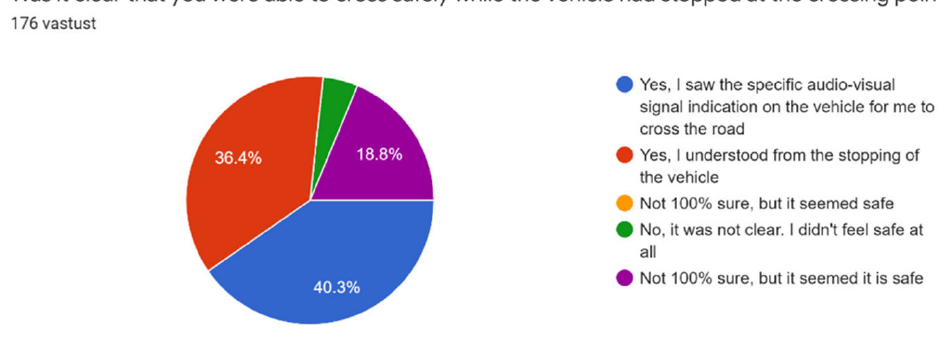
Figure 3. Answers to the question “Was it clear that you were able to cross safely while the vehicle had stopped at the crossing point?”.